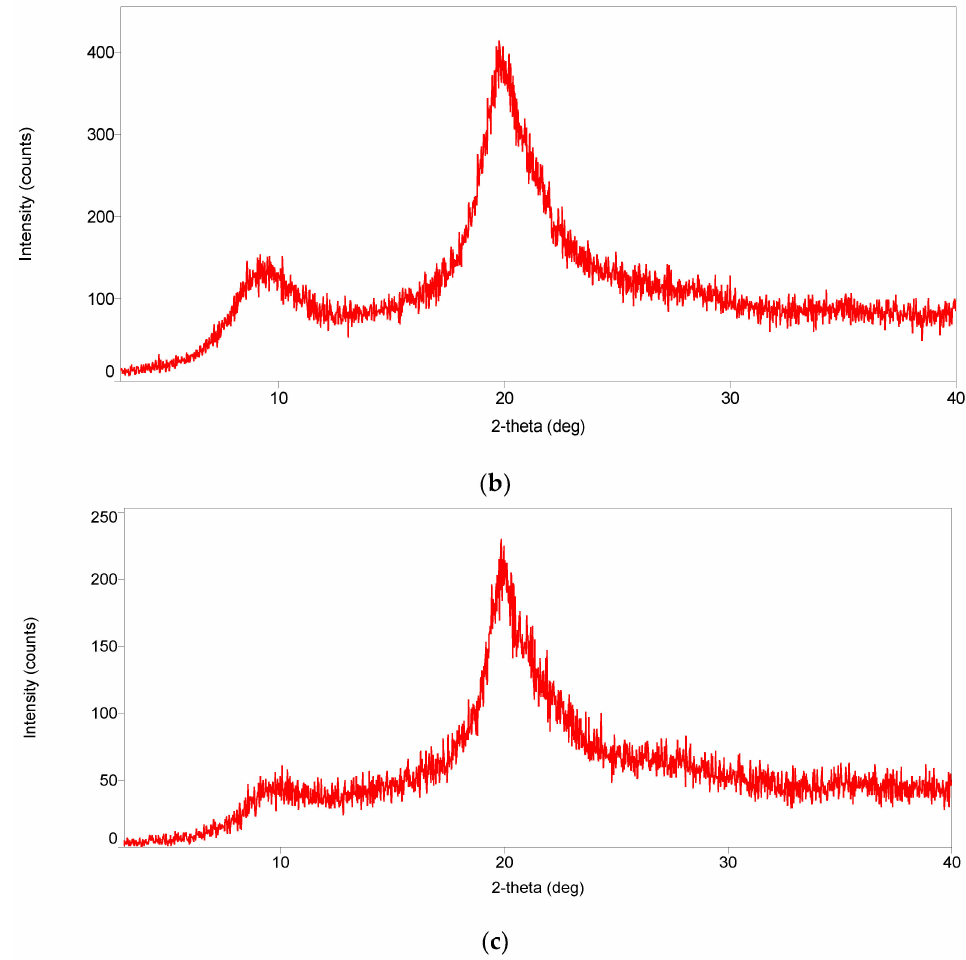
Figure 4. ( a ) XRD spectra of raw dry carapace powder of M. rosenbergii . ( b ) XRD spectra of chitosan from carapace of M. rosenbergii. ( c ) XRD spectra of commercial chitosan. Table 5. Design matrix and BBD experimental results of turbidity and salinity removal using chitosan from carapace of M. rosenbergii